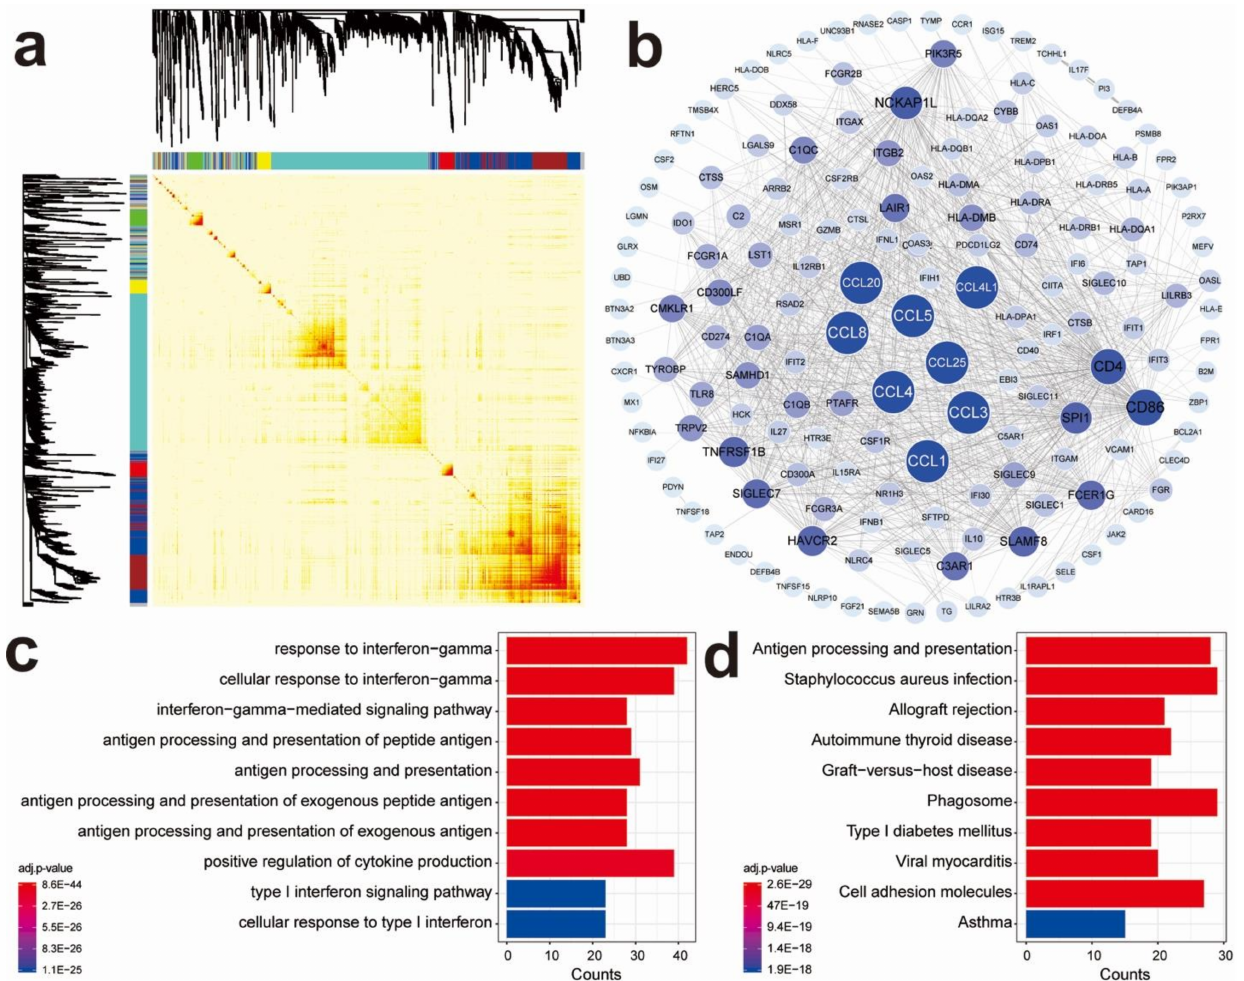
Figure 1. Identifying co-expressed immune genes related to CC chemokine genes by WGCNA. ( a ) Heat map of the Topological Overlap Matrix in WGCNA analysis; ( b ) co-expression network of genes in the blue module; ( c ) GO enrichment of genes in the blue module of co-expression network; ( d ) KEGG enrichment of genes in the blue module of co-expression